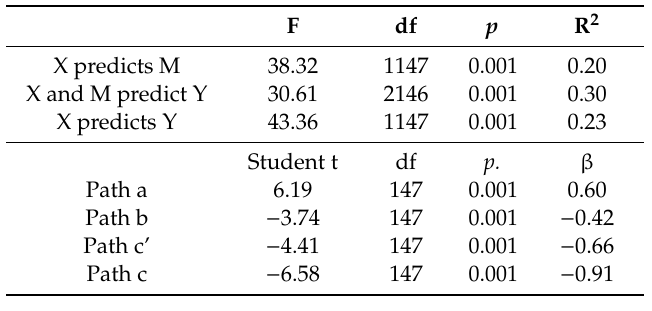
Table 6. Model 2 effect indices. In the table, the coefficients for all the effects of the mediation model number 2 are presented.